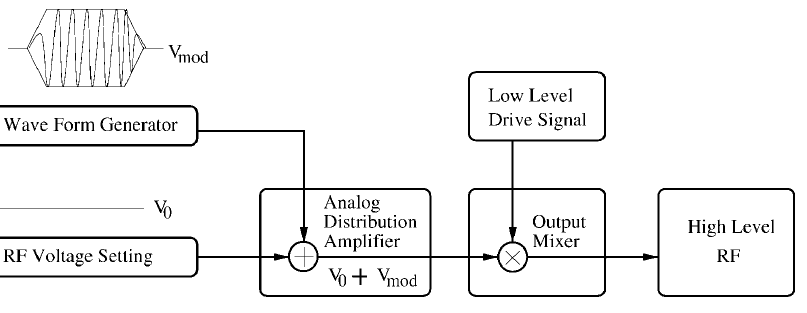
FIG. 2. Overview of the rf voltage modulation system.